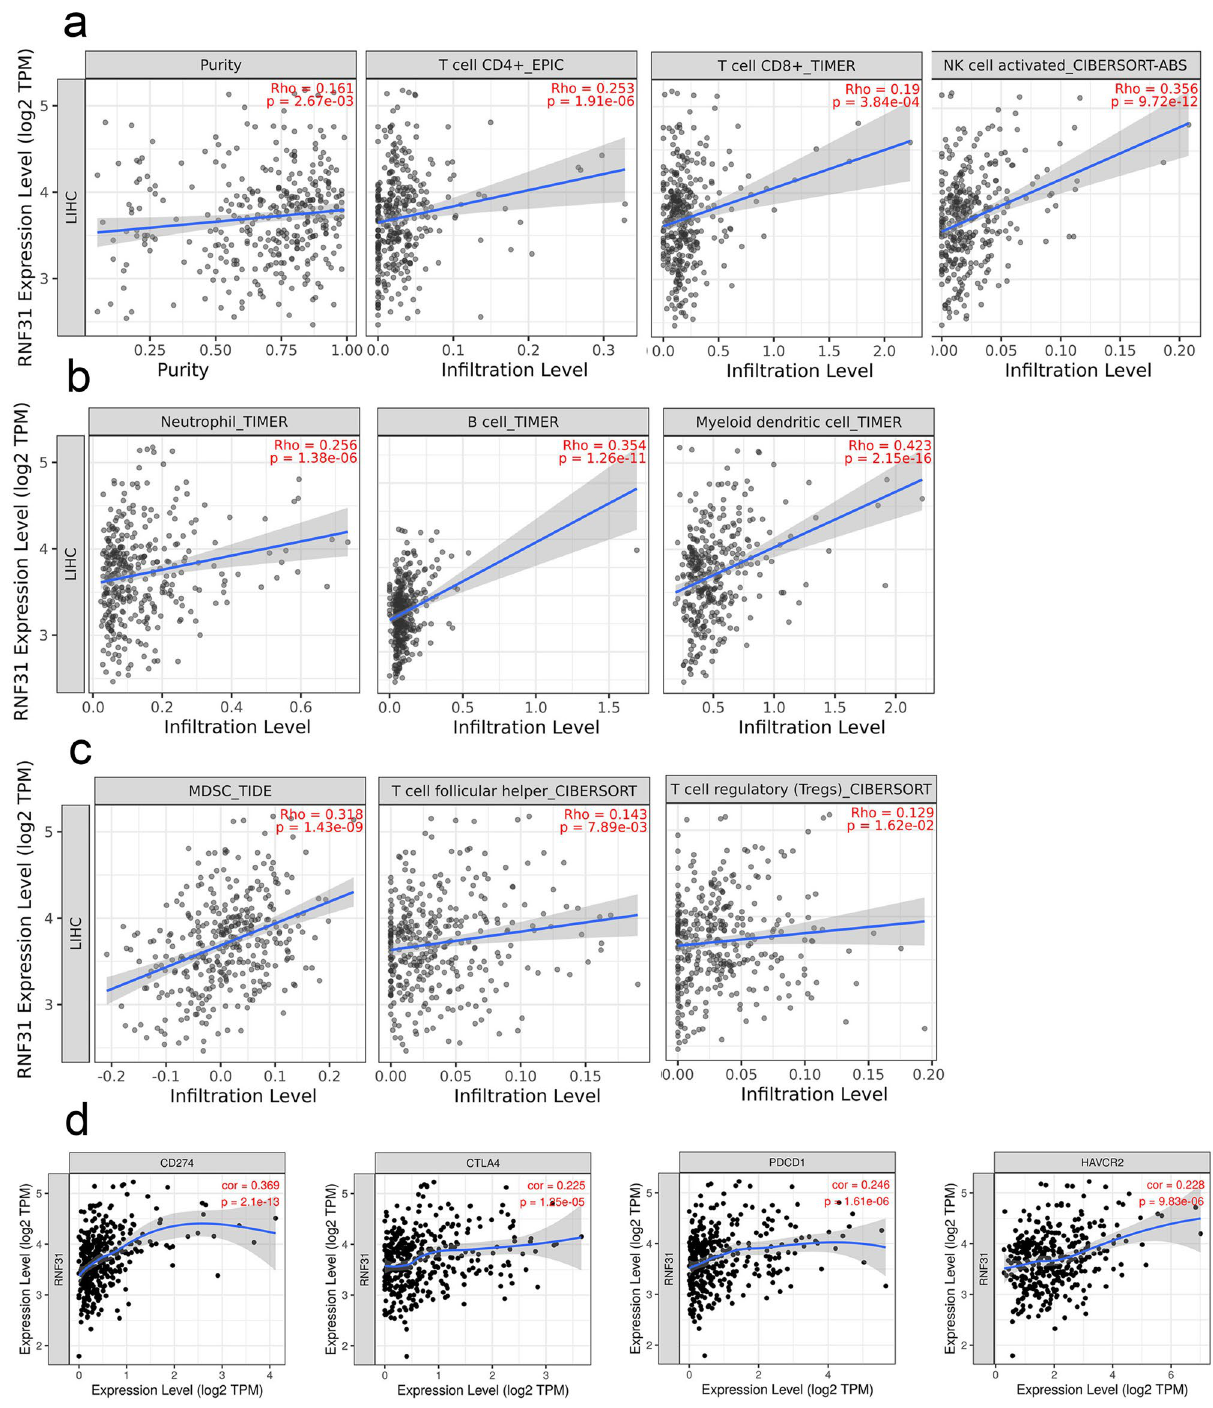
Figure 5. Correlation of RNF31 expression with the levels of infiltrating immune cells in LIHC. ( a ) RNF31 expression was significantly positively correlated with the levels of infiltrating CD4 + T cells, CD8 + T cells and activated NK cells. ( b ) RNF31 expression was significantly positively correlated with the levels of infiltrating neutrophils, B cells and myeloid dendritic cells. ( c ) RNF31 expression was significantly positively correlated with the levels of infiltrating myeloid-derived suppressor cells (MDSCs), follicular T cells and regulatory T cells (Tregs). ( d ) RNF31 was positively correlated with CD274, CTLA4, PDCD1 and HAVCR2 expression in